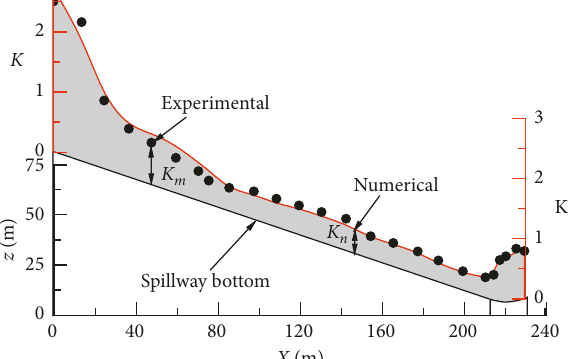
Figure 14: Relationship between ICA and